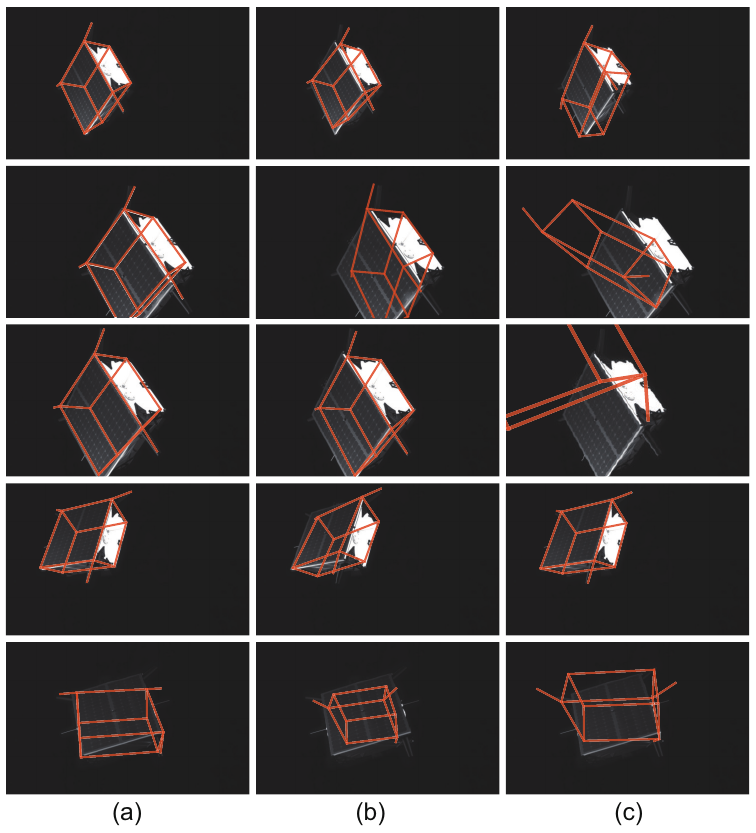
Figure 5. Pose Estimation Performance in five real images. ( a ) Ours, ( b ) Park [18], ( c ) Chen